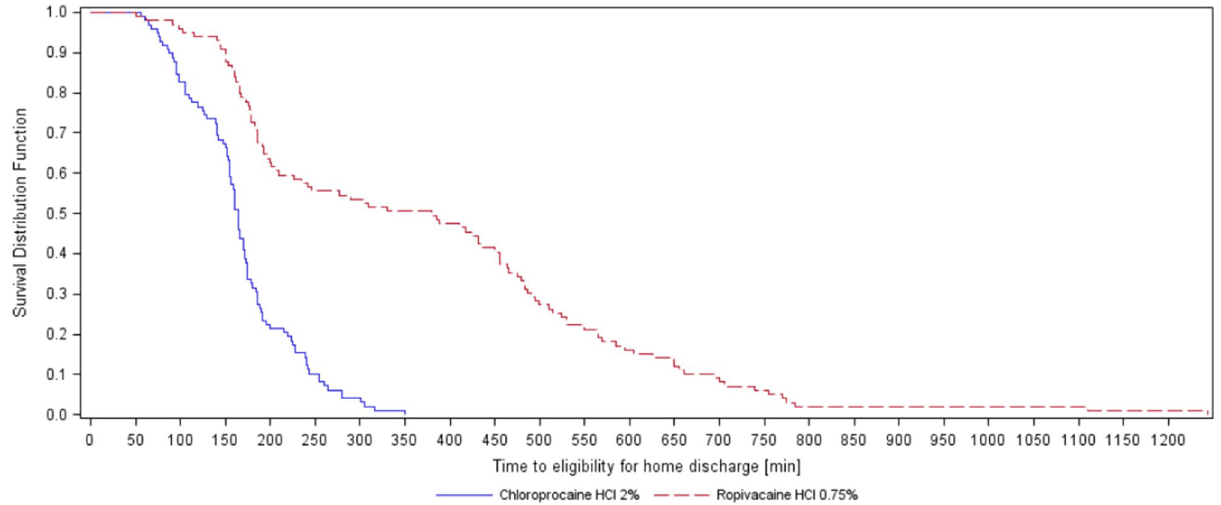
Figure 4. Time to eligibility of home discharge